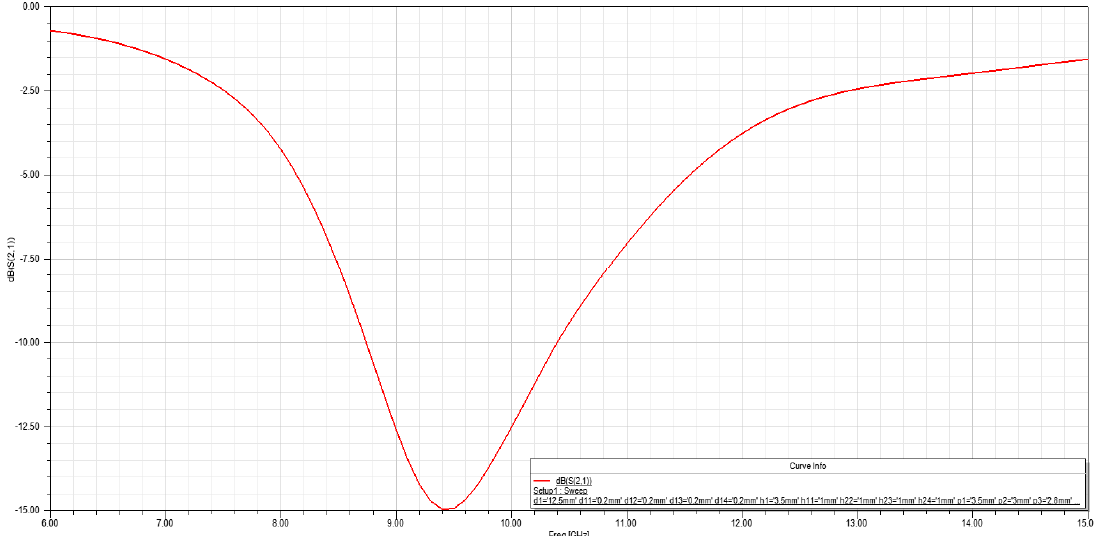
Figure 17. Imposed equalizer attenuation curve (magnitude of S 21 ) vs. frequency for the four cascade resonators.